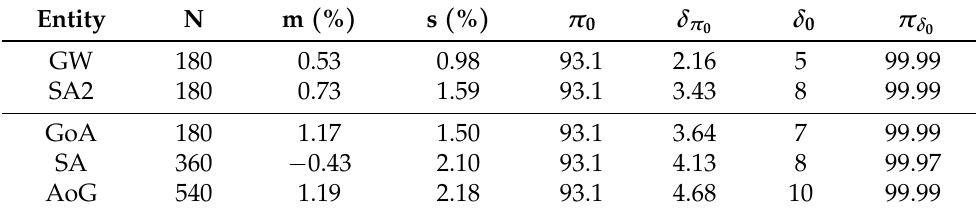
Table 4. Performance for valid T2S3 (Class A).